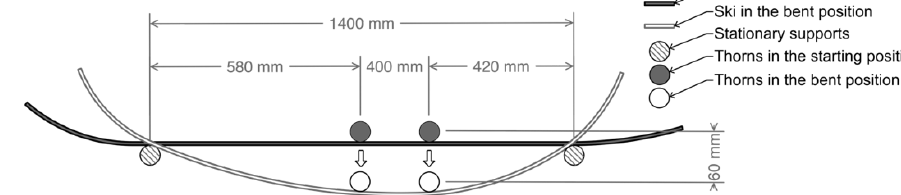
Figure 4. View at the ski in the testing position.